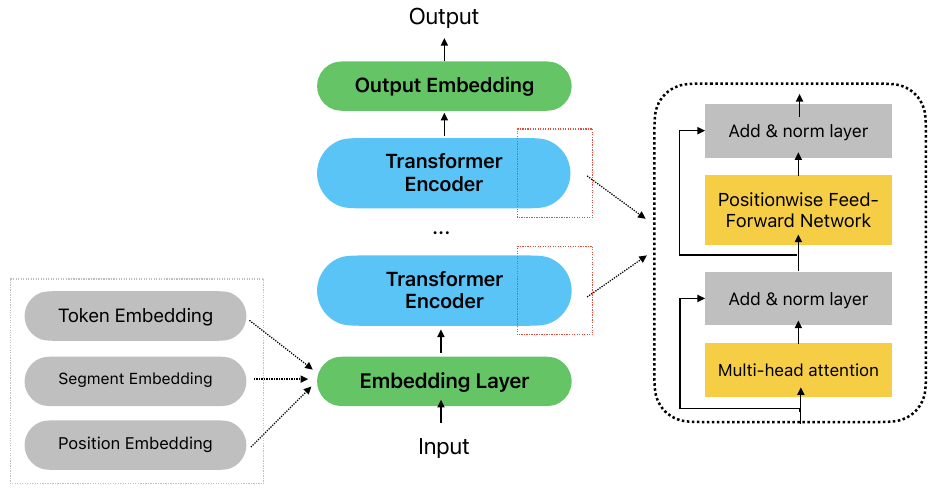
Figure 1. The architecture of pre-trained BERT